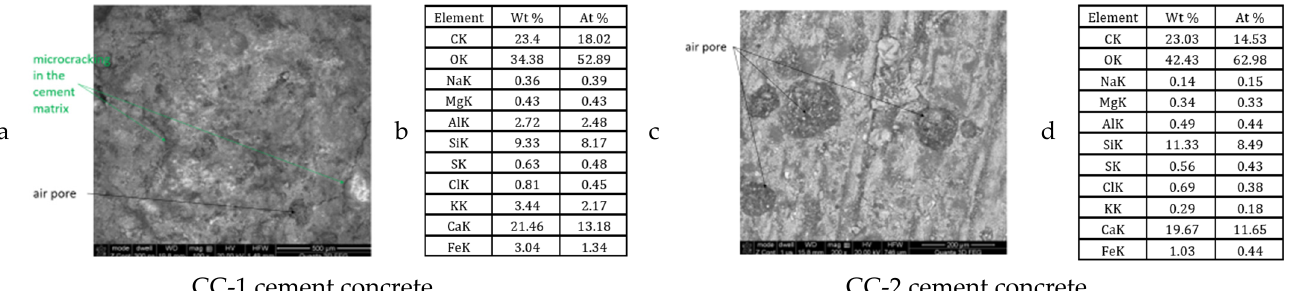
Figure 24. Concrete subjected to thermal cycles according to scheme B for CC-1 and CC-2 concrete: ( a , c ) sample surface, ( b , d ) chemical microanalysis.